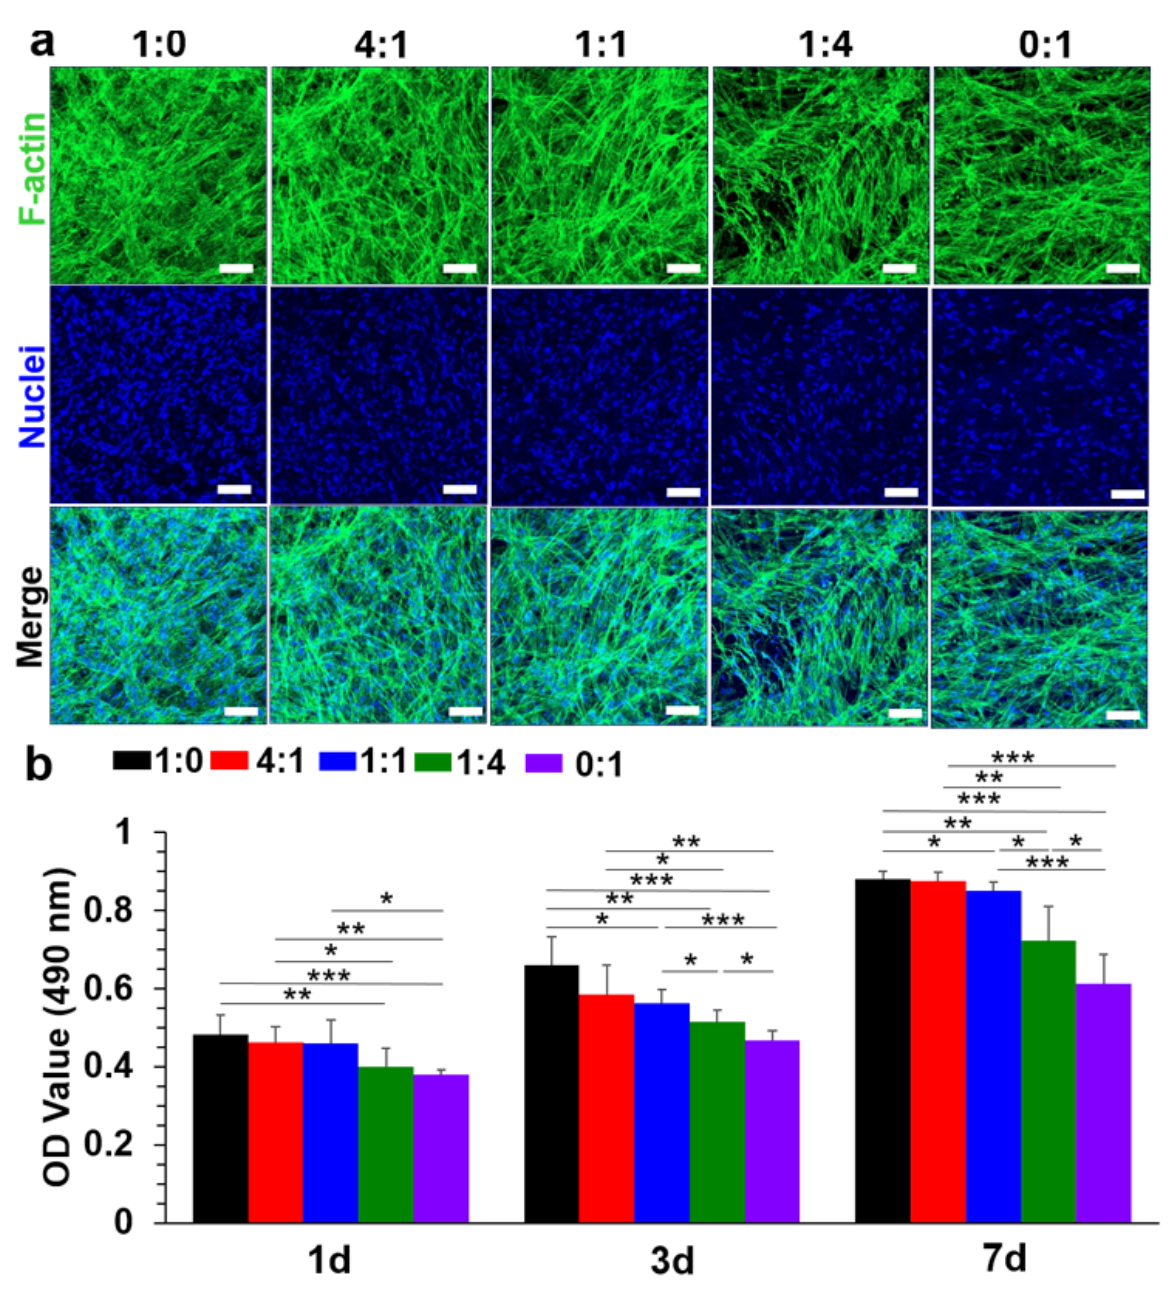
Figure 7. ( a ) The F ‐ actin (green) and nuclei (blue) immunofluorescent staining of human dermal fibroblasts cultured on different crosslinked MeGel/PLLA nanofiber mats at day 7. Scale bars = 100 μ m. ( b ) The MTT assay results of human dermal fibroblasts cultured on different crosslinked MeGel/PLLA nanofiber mats over 7 days (n = 5; * p < 0.05, ** p < 0.01, *** p < 0.001).